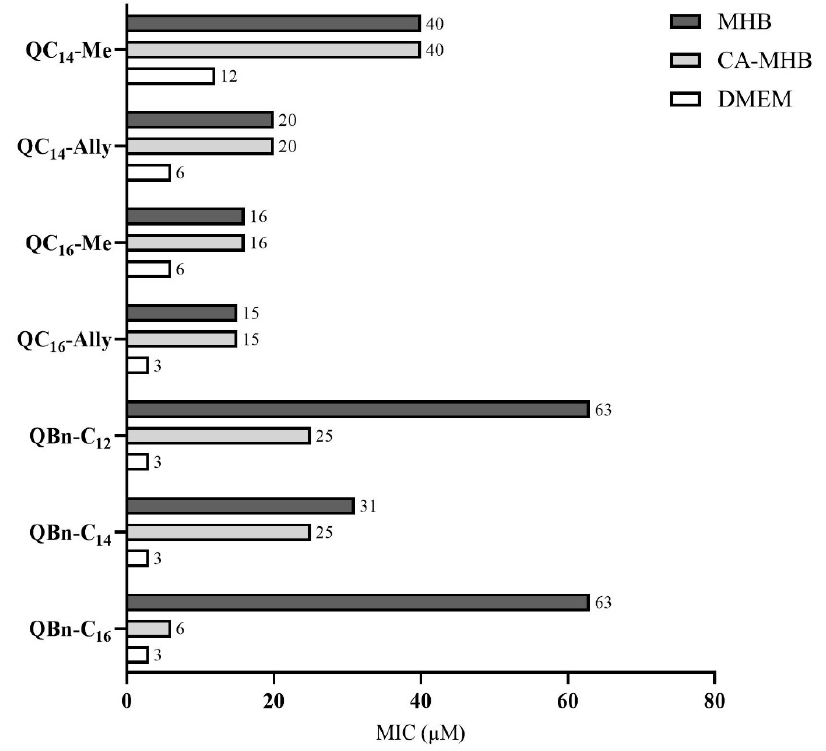
Figure 2. Minimal inhibitory concentrations ( μ M (cid:4667) in Mueller–Hinton Broth (MHB), cation ‐ adjusted MHB, and Dulbecco’s Modified Eagle Medium (DMEM) for selected candidate quaternary ammo ‐ nium compounds against Staphylococcus aureus ATCC 25923.